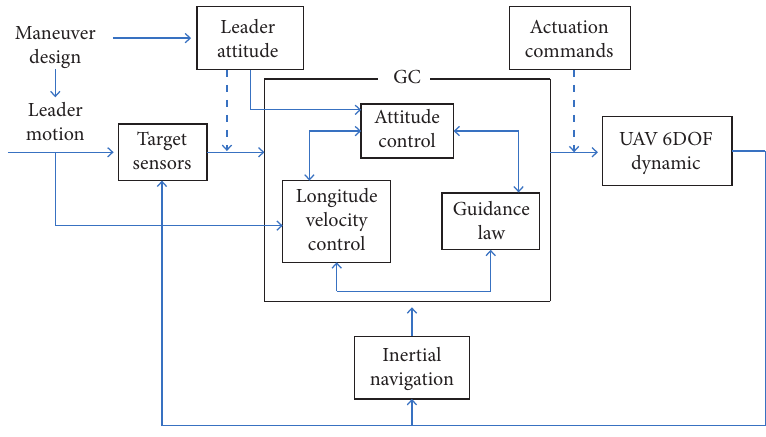
Figure 2. Tracking